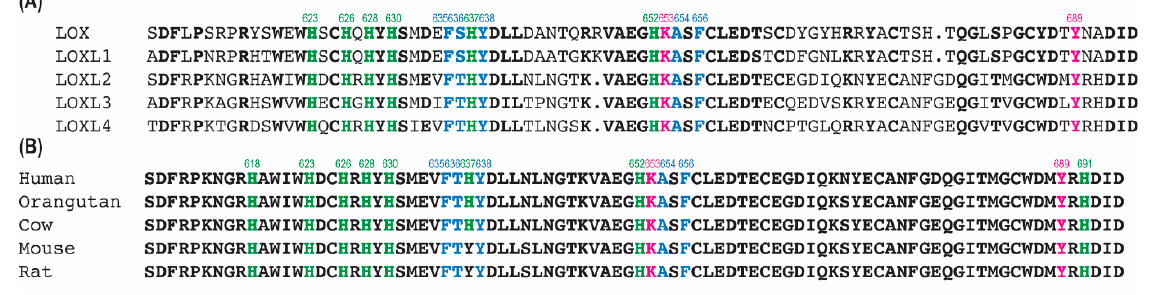
Figure 4. Amino acid sequence alignment of ( A ) human LOX − family of proteins and ( B ) mammalian LOXL2s. The precursor residues (Lys653 and Tyr689) of LTQ are in pink, His residues are in green and conserved His residues are in bold. Residues that comprise the hydrophobic patch (Figure 3) are in blue. Numbering of residues are that of human LOXL2. Multiple sequence alignment was conducted by COBALT (https://www.ncbi.nlm.nih.gov/tools/cobalt/re_cobalt.cgi).